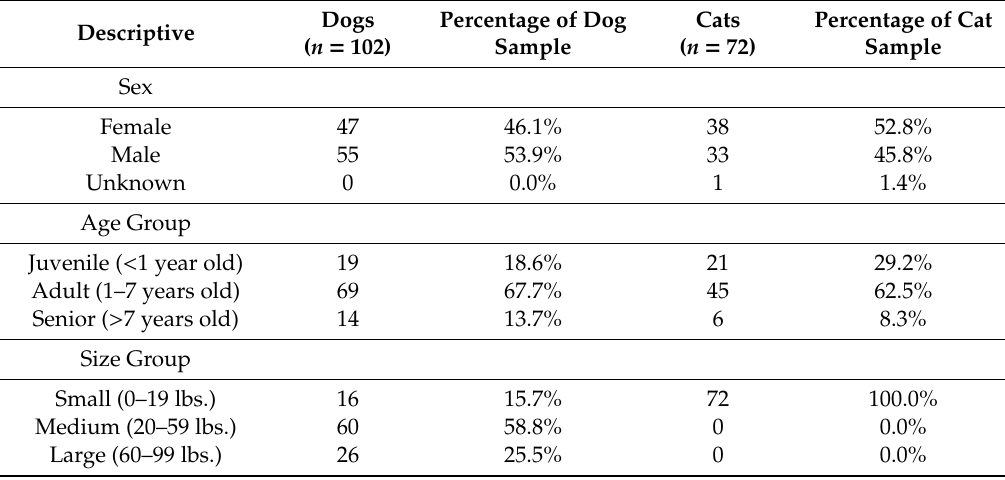
Table 2. Description of the sample of dogs ( n = 102) and cats ( n = 72) by number of animals and percentage of the